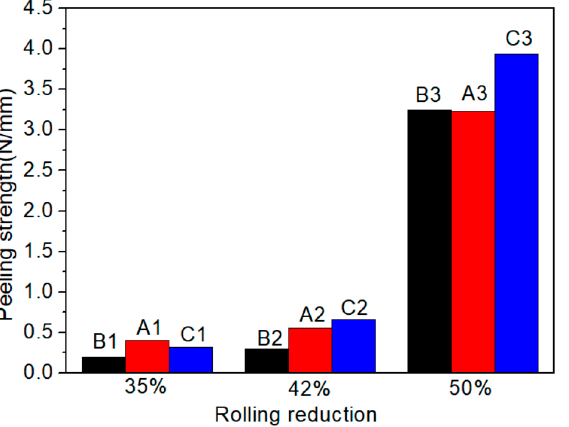
Figure 4. Variation of peel strength of specimens A, B and C with reduction.